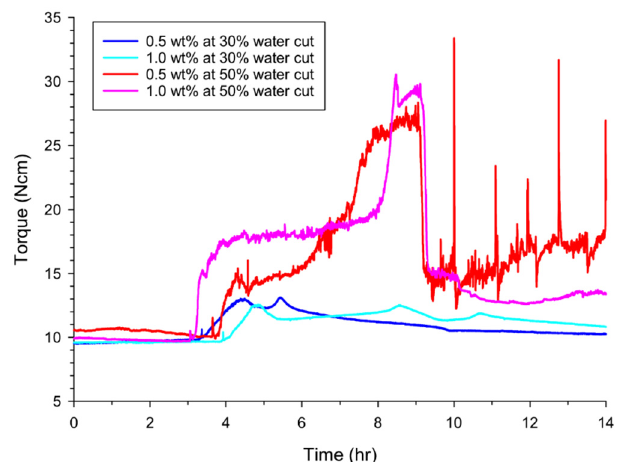
Figure 4. Anti-agglomeration effects of Span 80 depending on the concentrations added. Hydrate formation kinetics (or rotational torques) were measured at two water cuts of 30% and 50% with two concentrations of 0.5 and 1.0 wt%.